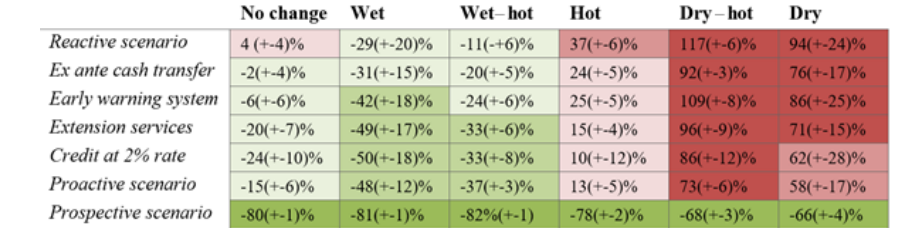
Table 2. Change in aid needs (%) in 2030–2050 compared to 1980–2000 (average and standard deviation introduced by sensitivity analysis – variation caused by different model initializations and by the different relative importance of the PMT factors for the decisions of households) under different climate and policy intervention scenarios. ADOPT model